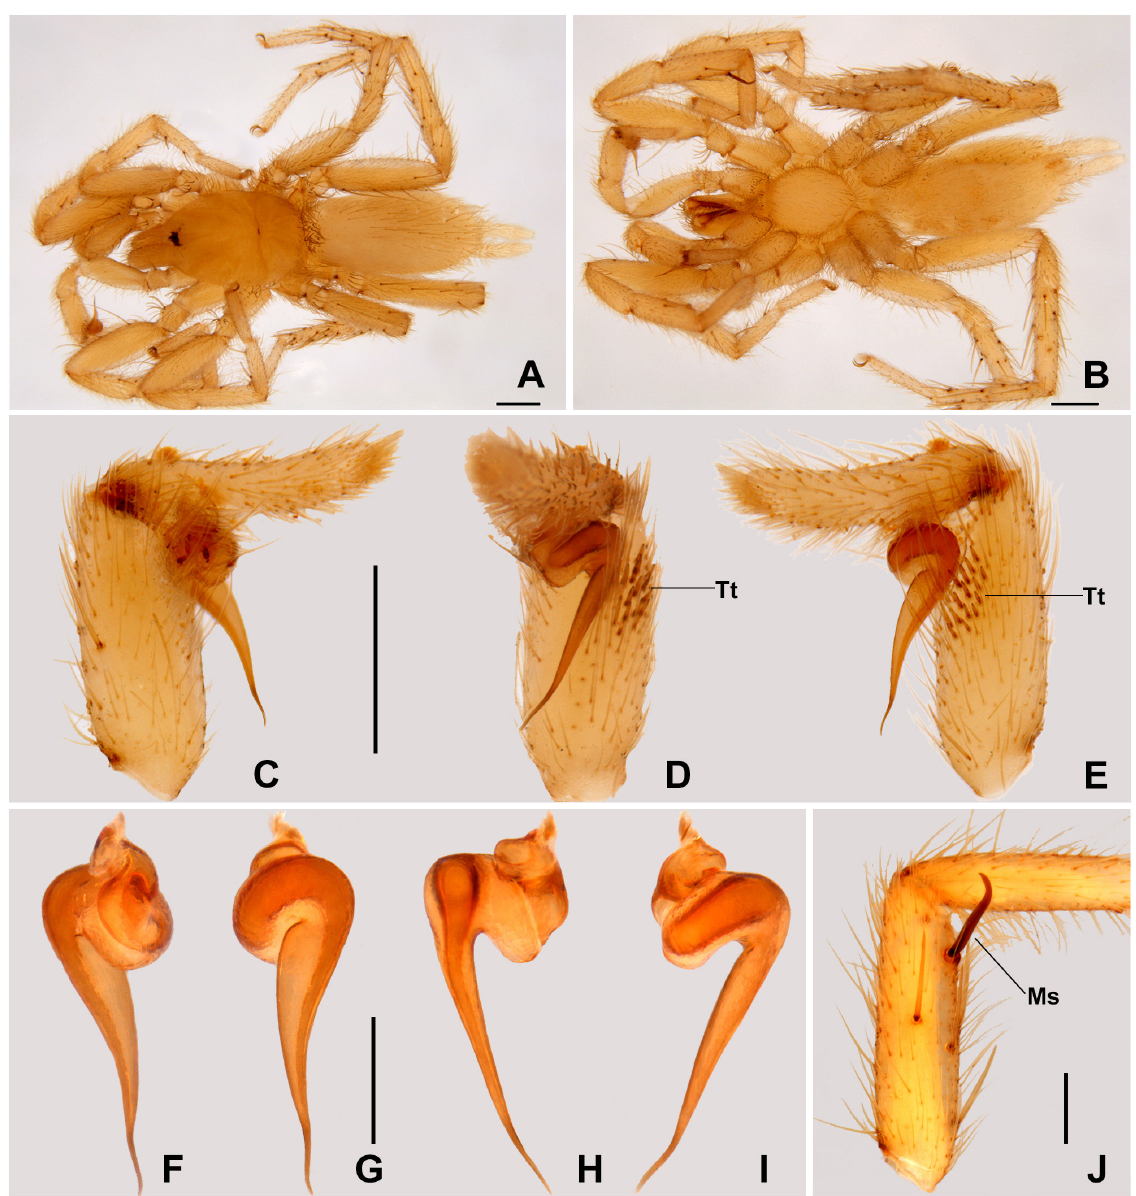
Fig. 8. Ammonius benoiti sp. nov. A–E . Holotype, ♂ (RMCA 202482). A . Habitus dorsal. B . Habitus ventral. C–E . Male palp. C . Prolateral view. D . Ventral view. E . Retrolateral view. F–J . Paratype, ♂ (RMCA 202354), male palpal bulb. F . Ventral view. G . Dorsal view. H . Prolateral view. I . Retrolateral view. J . Tibia I, prolateral view. Abbreviations: Ms = Megaspine; Tt = Tibial thorns. Scale bars: A–E, J = 0.5 mm; F– I = 0.2